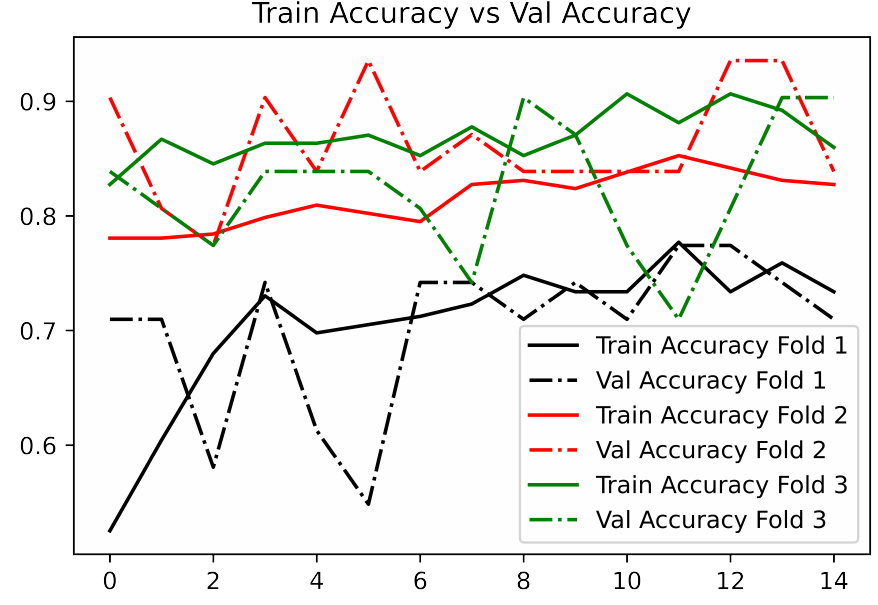
Figure 9. Training and validation accuracy using 14 epochs in 2D-CNN with 3 fold cross-validation.